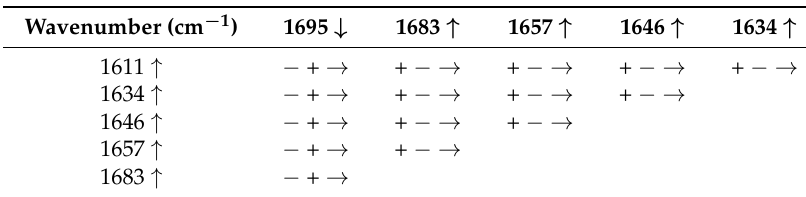
Table 4. Correlation table for deconvolved FTIR spectra of ICFs (5% w / v in D 2 O) upon cooling (70 → 5 °C, in decrement of 5 °C).